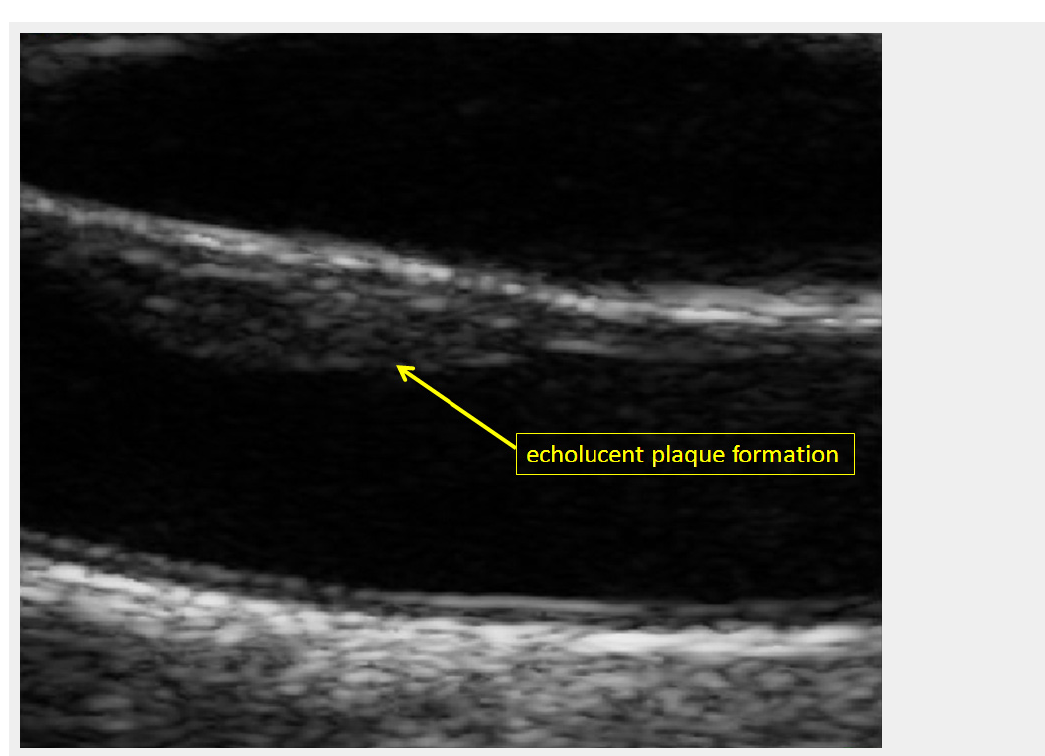
Figure 2 Echolucent carotid plaque formation at the near wall of the right common carotid artery (male study participant of the population-based Heinz Nixdorf Recall study)